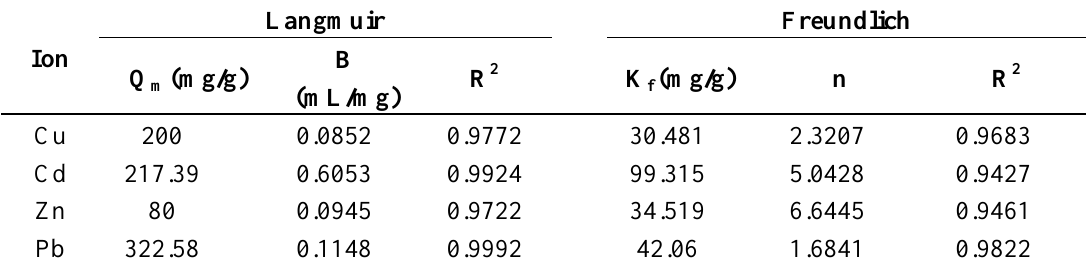
Table 3. Adsorption isotherm constants and correlation coefficients of two models. Langmuir Ion